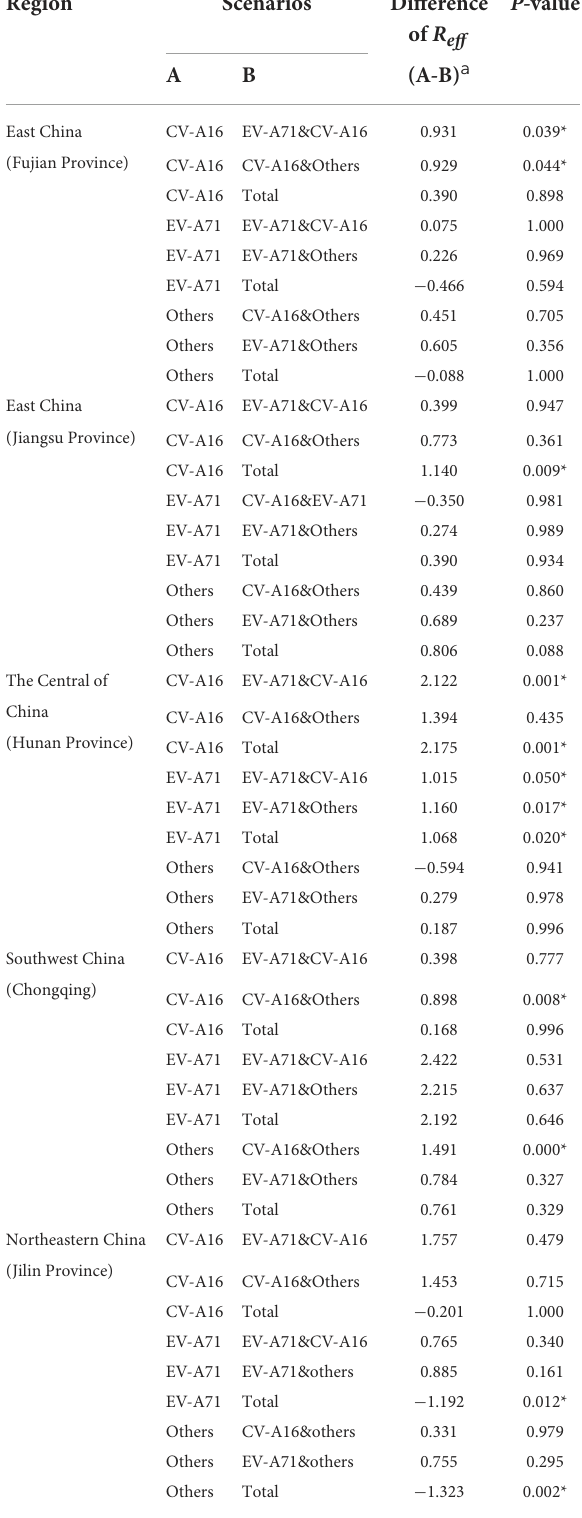
TABLE 3 Interaction pattern of different pathogens of HFMD.